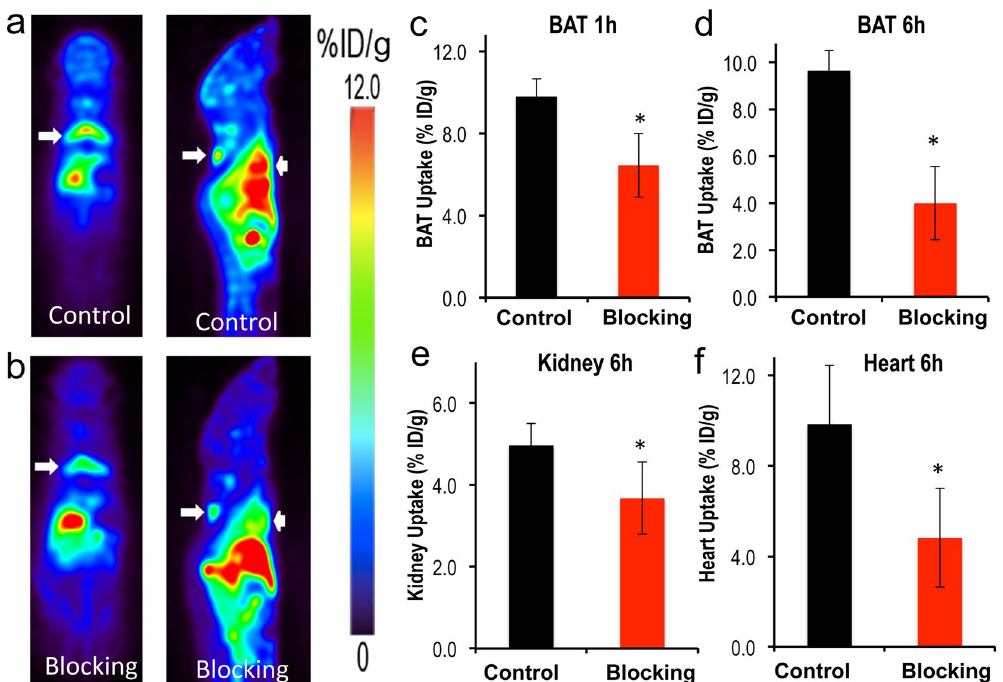
Figure 3. Blocking studies with TSPO ligand F-DPA. ( a ) Representative PET images of mice injected with 64 Cu-Dis without blocking. ( b ) Representative PET images of mice with 64 Cu-Dis with F-DPA blocking. The decreased uptake of 64 Cu-Dis can be observed in BAT (white arrow) and heart (arrow head). ( c ) Quantitative analysis of BAT uptake at 1 hour, ( d ) Quantitative analysis of BAT uptake at 6 hours, ( e ) Quantitative analysis of kidney uptake at 6 hours, and ( f ) quantitative analysis of heart uptake at 6 hours. * Indicates p <